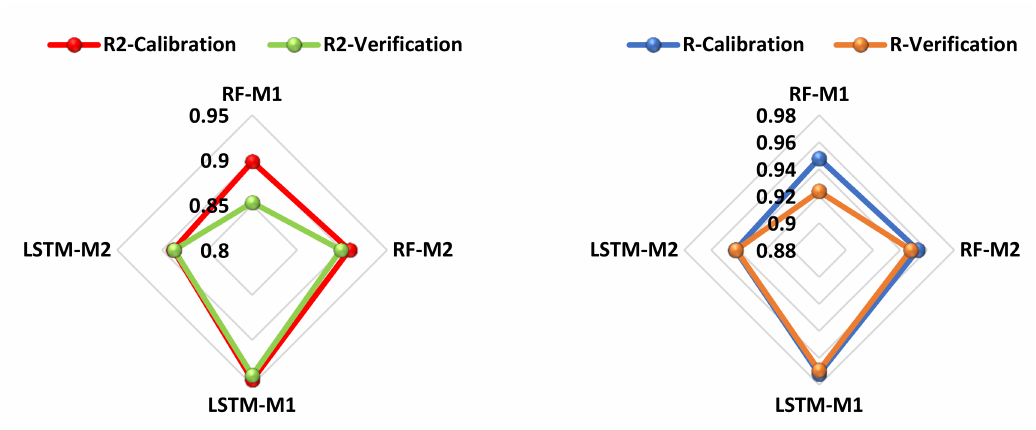
Figure 14. Radar chart for all of the models for R 2 and